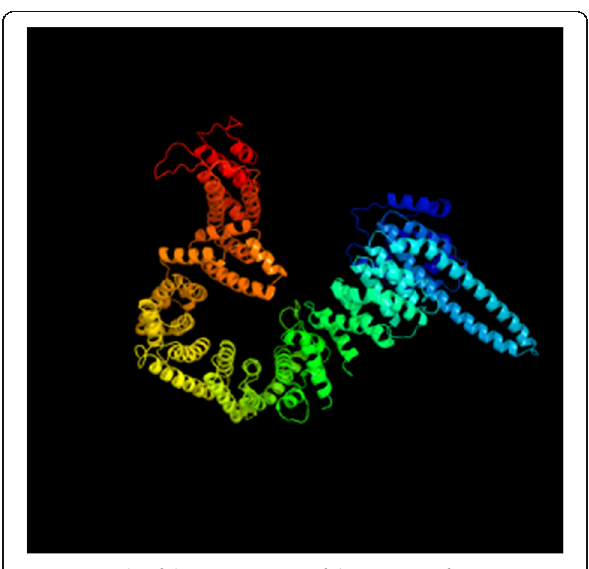
Fig. 5 Example of the 3-D structure of the STAG3 isoform 1